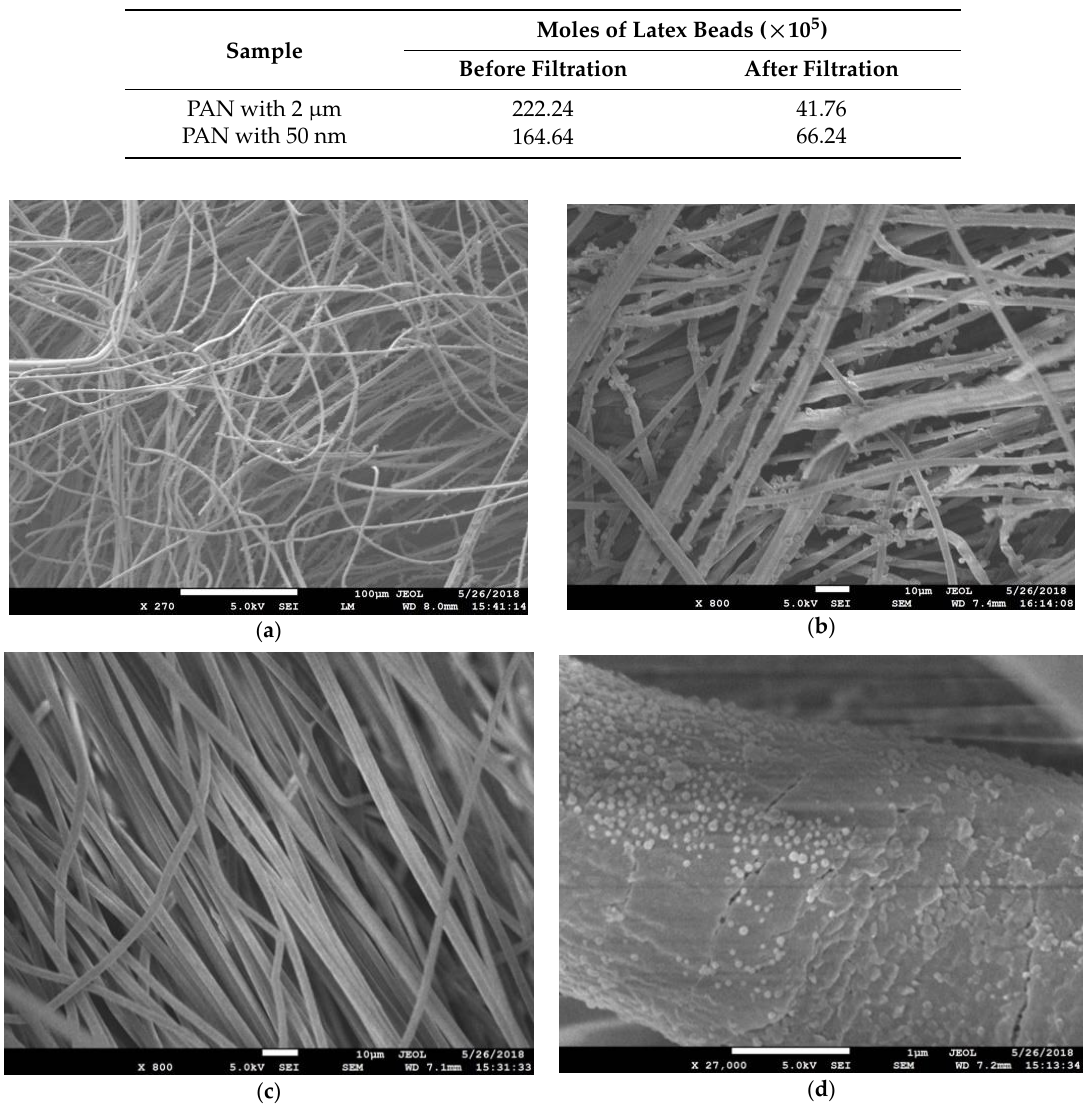
Figure 7. Filter membrane sample after filtration of solution with latex beads: ( a ) PAN with 2 µm latex beads at ×270 magnification; ( b ) PAN with 2 µm latex beads at ×800 magnification; ( c ) PAN with 50 nm latex beads at ×800 magnification; ( d ) PAN with 50 nm latex beads at ×27,000 magnification.